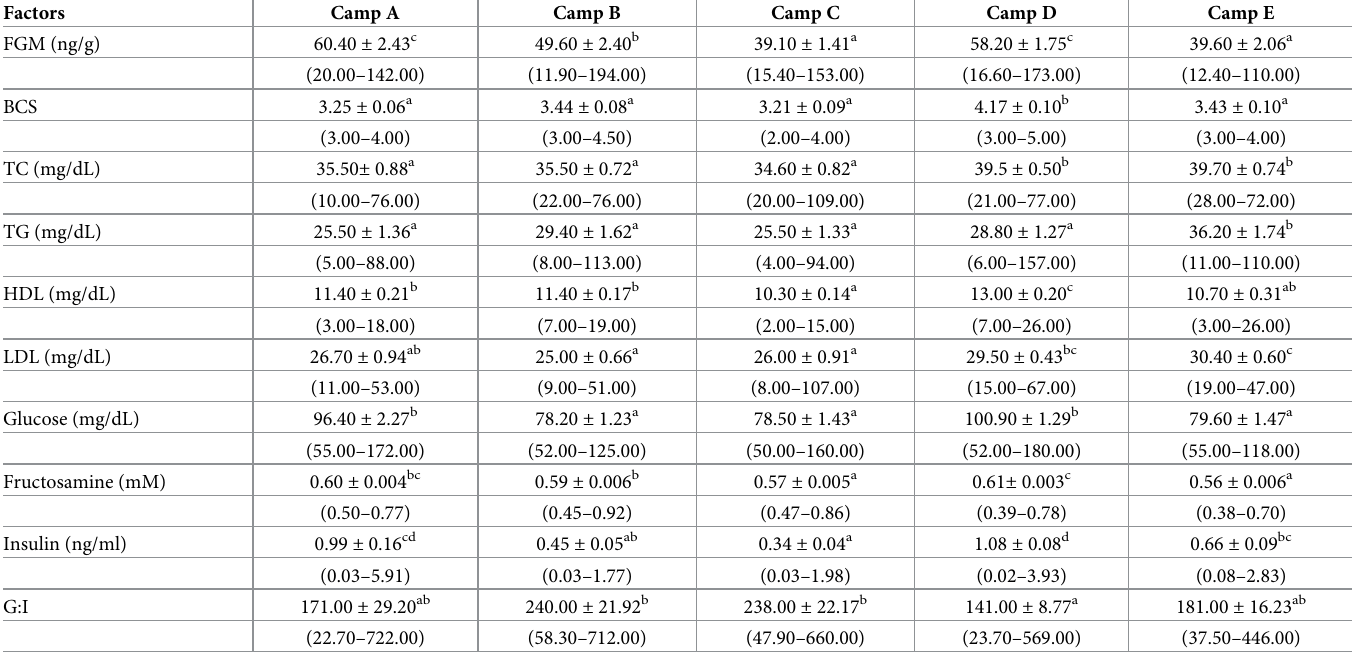
Table 2. Differences in FGM, metabolic and lipid measures in captive elephants under different management conditions. Mean ( ± SEM) and range values (min– max) are presented. Fecal samples were collected for glucocorticoid analyses, and visual body condition scores were determined based on a set of photographs. Blood sam- ples were collected to assess lipid and metabolic status for 1 year including High and Low season. The elephants were housed at five elephant camps in Northern Thailand, and studied to determine how management (e.g., work activities, feeding, work type) affected physiological function.